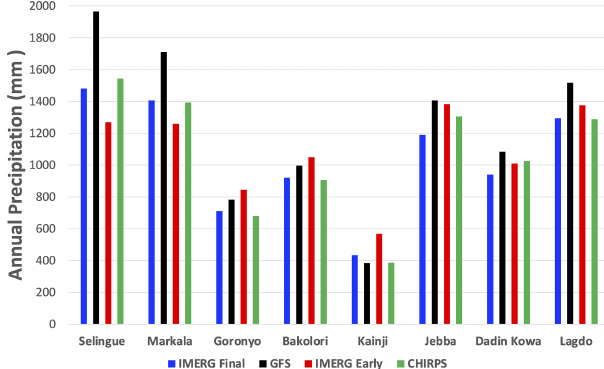
Figure 4. Subbasin-averaged annual precipitation (millimeters) for the period 15 June 2019 to 15 June 2020, for each of the Niger’s subbasins, derived from the 1d lead time GFS forecast and different satellite precipitation